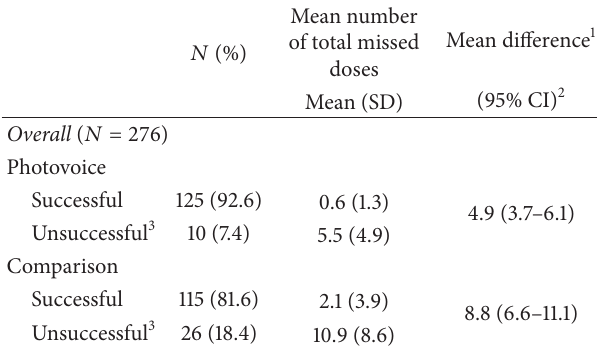
Table 2: Mean number of antituberculosis drug doses missed among TB patients who viewed Photovoice and comparison group who did not by treatment